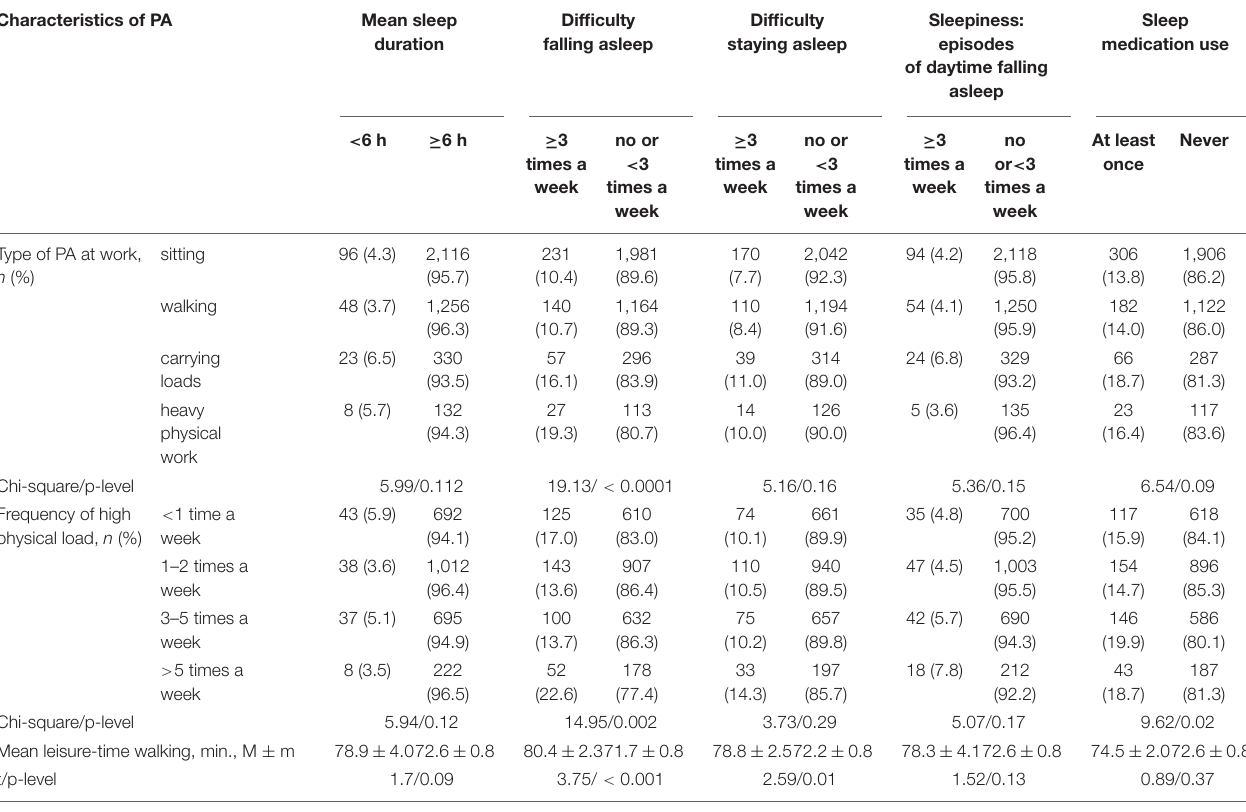
TABLE 2 | Physical activity (PA) and sleep characteristics.